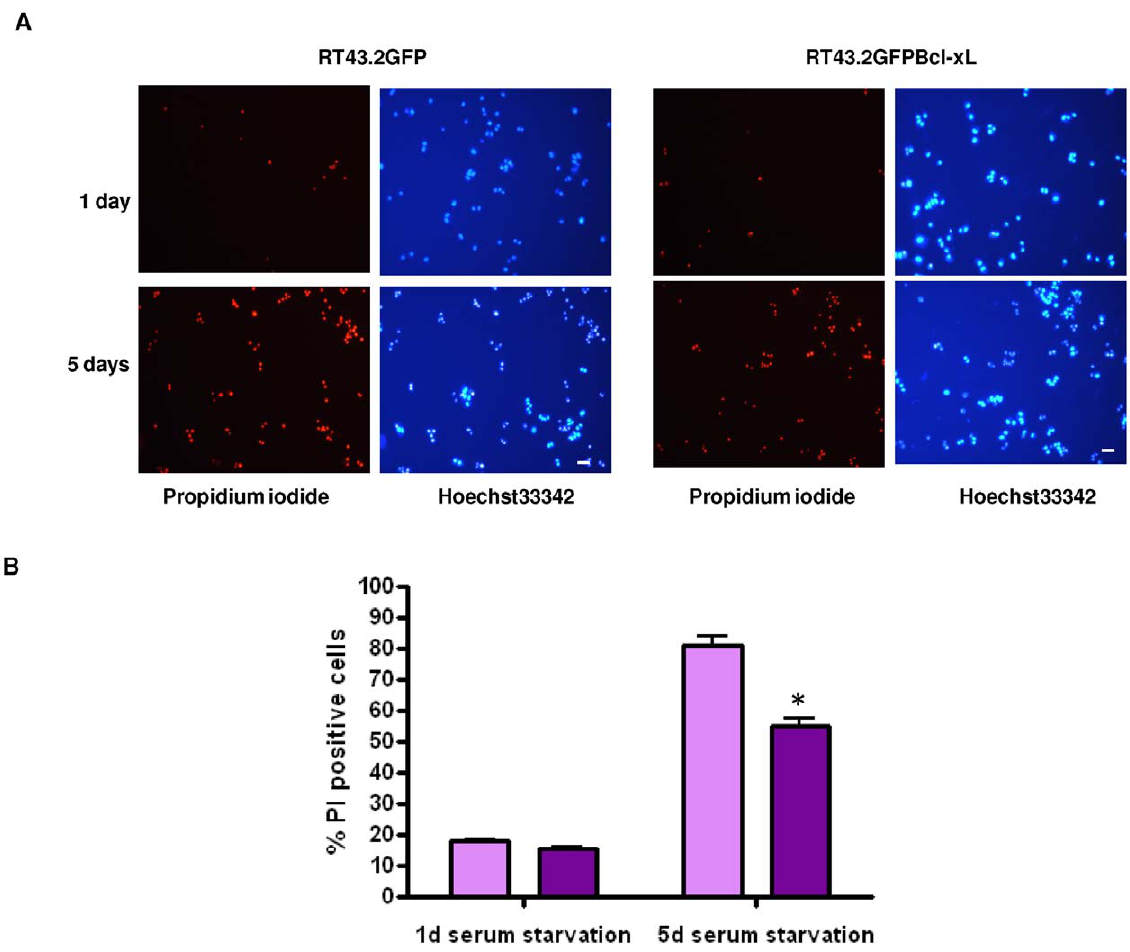
Figure 6. RT43.2GFPBcl-xL vector exposure decreased PC12 cell death induced by serum withdrawal. A . Undifferentiated PC12 cells on Matrigel-coated wells were transduced with control RT43.2GFP (left four panels) or RT43.2GFPBcl-xL vectors (right four panels) and then serum was withdrawn for either one day (upper panels) or 5 days (lower panels). After either one or five days propidium iodide was used to stain dead cells, and total cell count was obtained by Hoechst33342 staining. The cells were photographed with a 20 6 objective using either a rhodamine (PI) or DAPI filter. Scale bars=20 m m. B . Propidium iodide (PI) stained dead cells and Hoechst33342 stained total cells were used to determine the effects of GFPBcl-xL expression (dark purple bar) compared to GFP expression alone (light purple bar) on cell viability. Percentage of PI positive cells versus Hoechst33342 stained total cells is represented by the mean value of several fields obtained from three experiments. *P , 0.01.